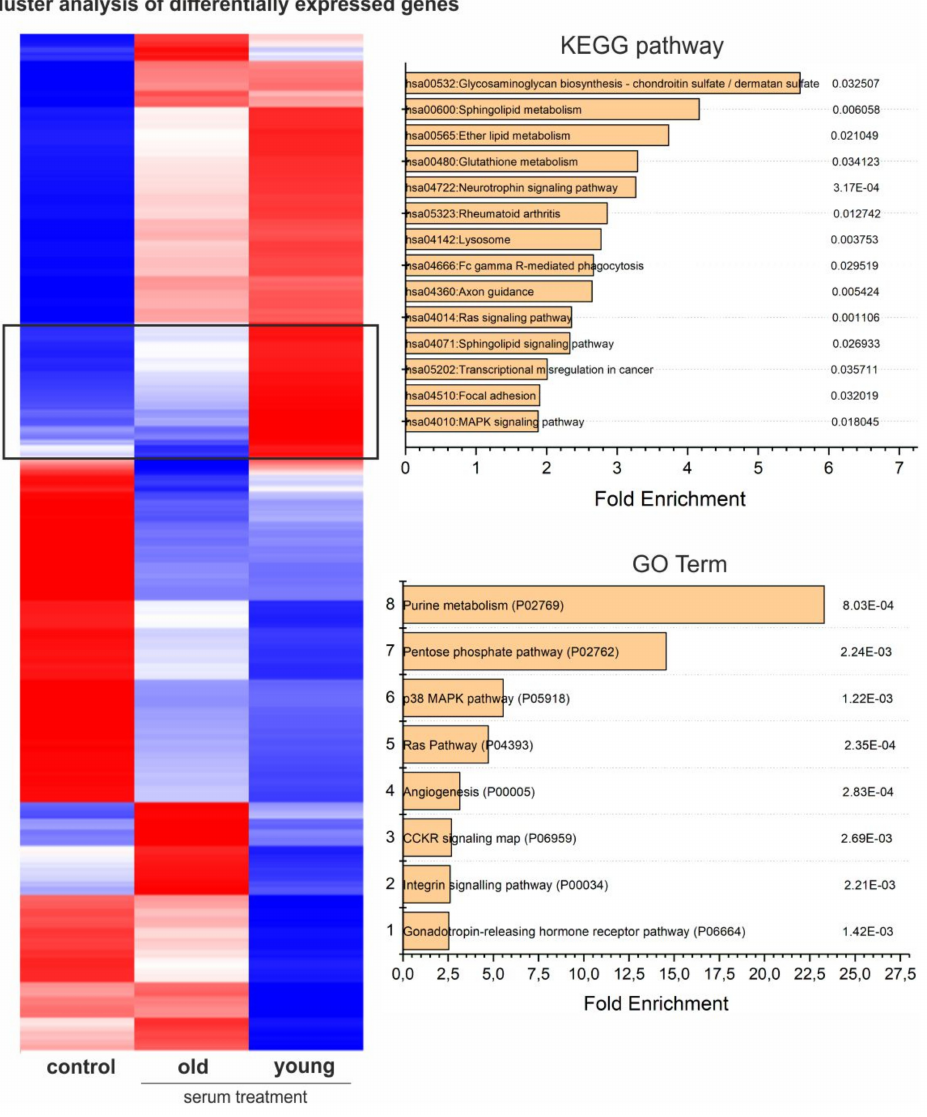
Figure 5. Heatmap of di ff erentially expressed genes with KEGG-pathway analysis and GO-term enrichment of genes highly upregulated in hCSCs treated with young serum and downregulated in hCSCs treated with old serum and in the control (cluster marked with black